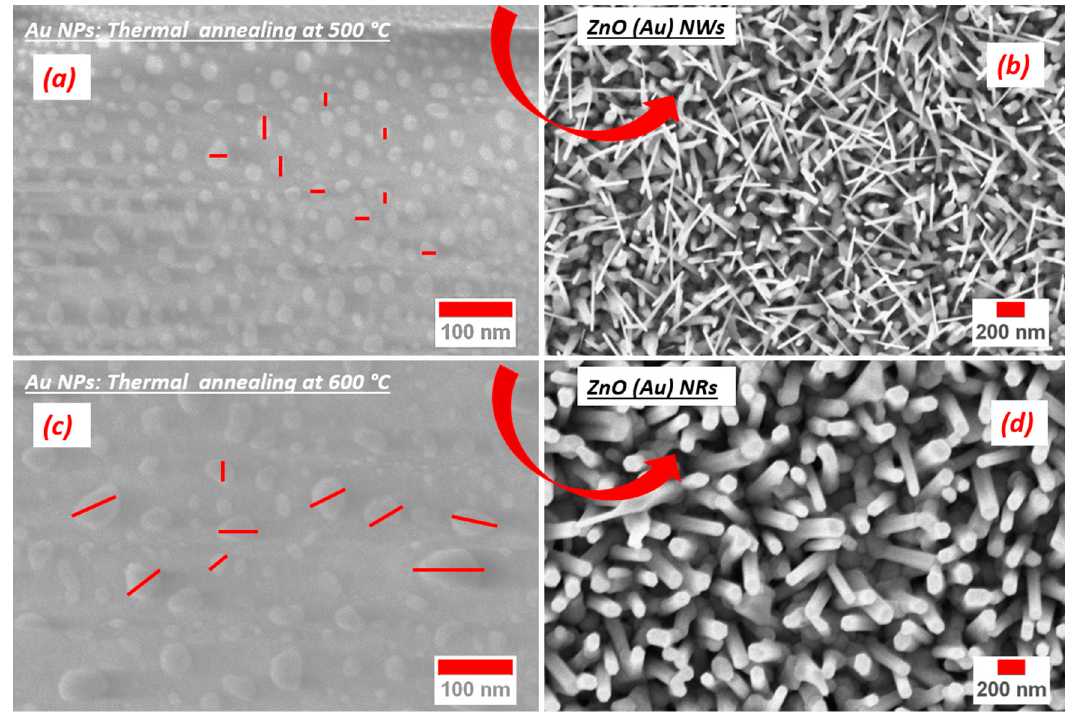
Figure 3. Au seed layer annealed at 500 ( a ) and 600 °C ( c ) without nano- (wire/rod) growth; High magnification ZnO nanowires ( b ) and ZnO nanorods ( d ) after growth.